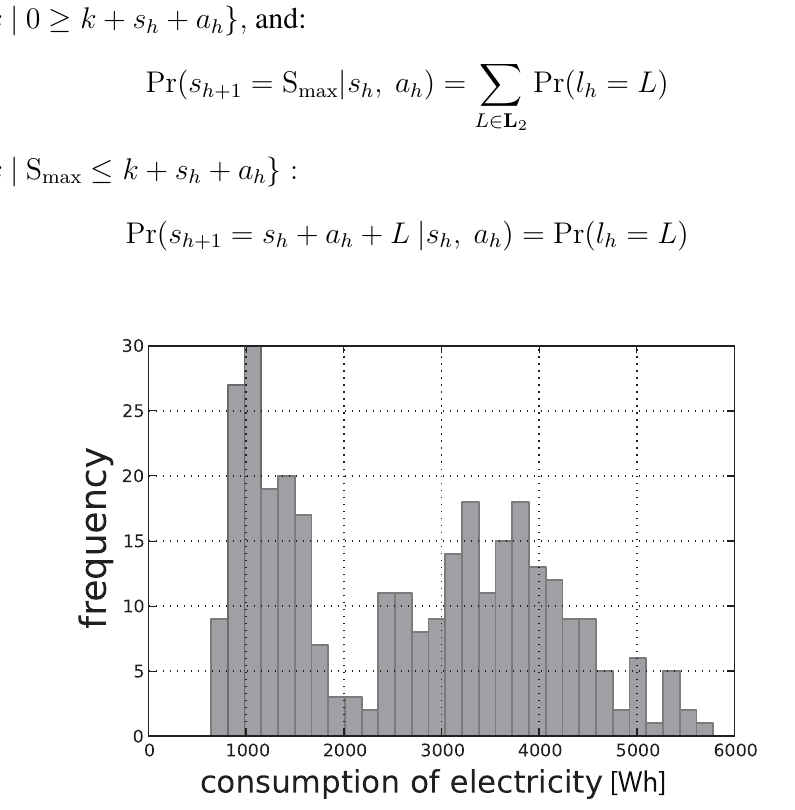
Figure 2. Histogram of the energy consumption from 7:30 a.m. to 8:00 a.m. for a representative